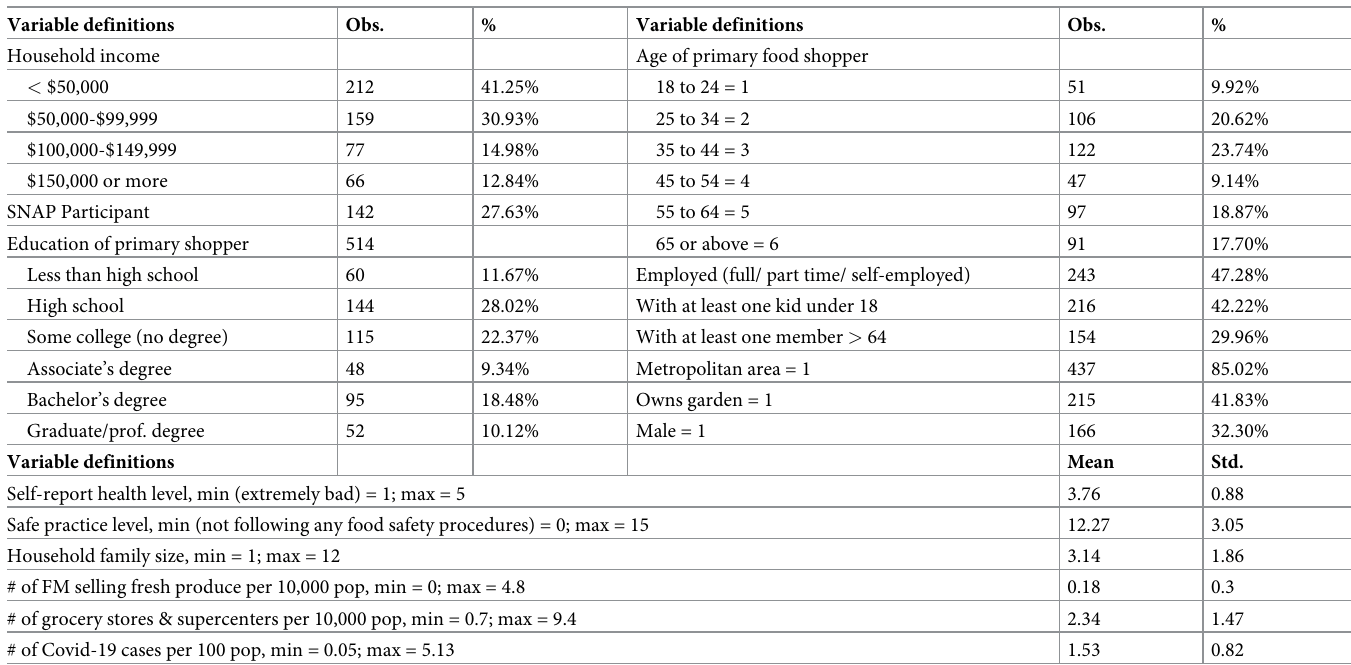
Table 1. Demographic information of the survey respondents and descriptions of the variables. Variable